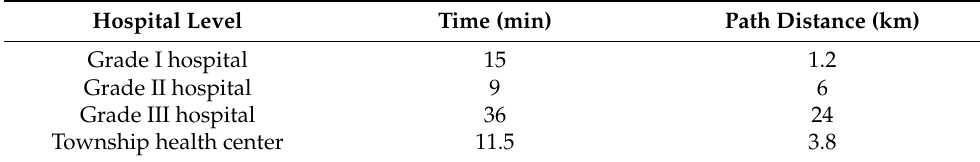
Table 3. The service radius (time and path distance) based on hospital size.